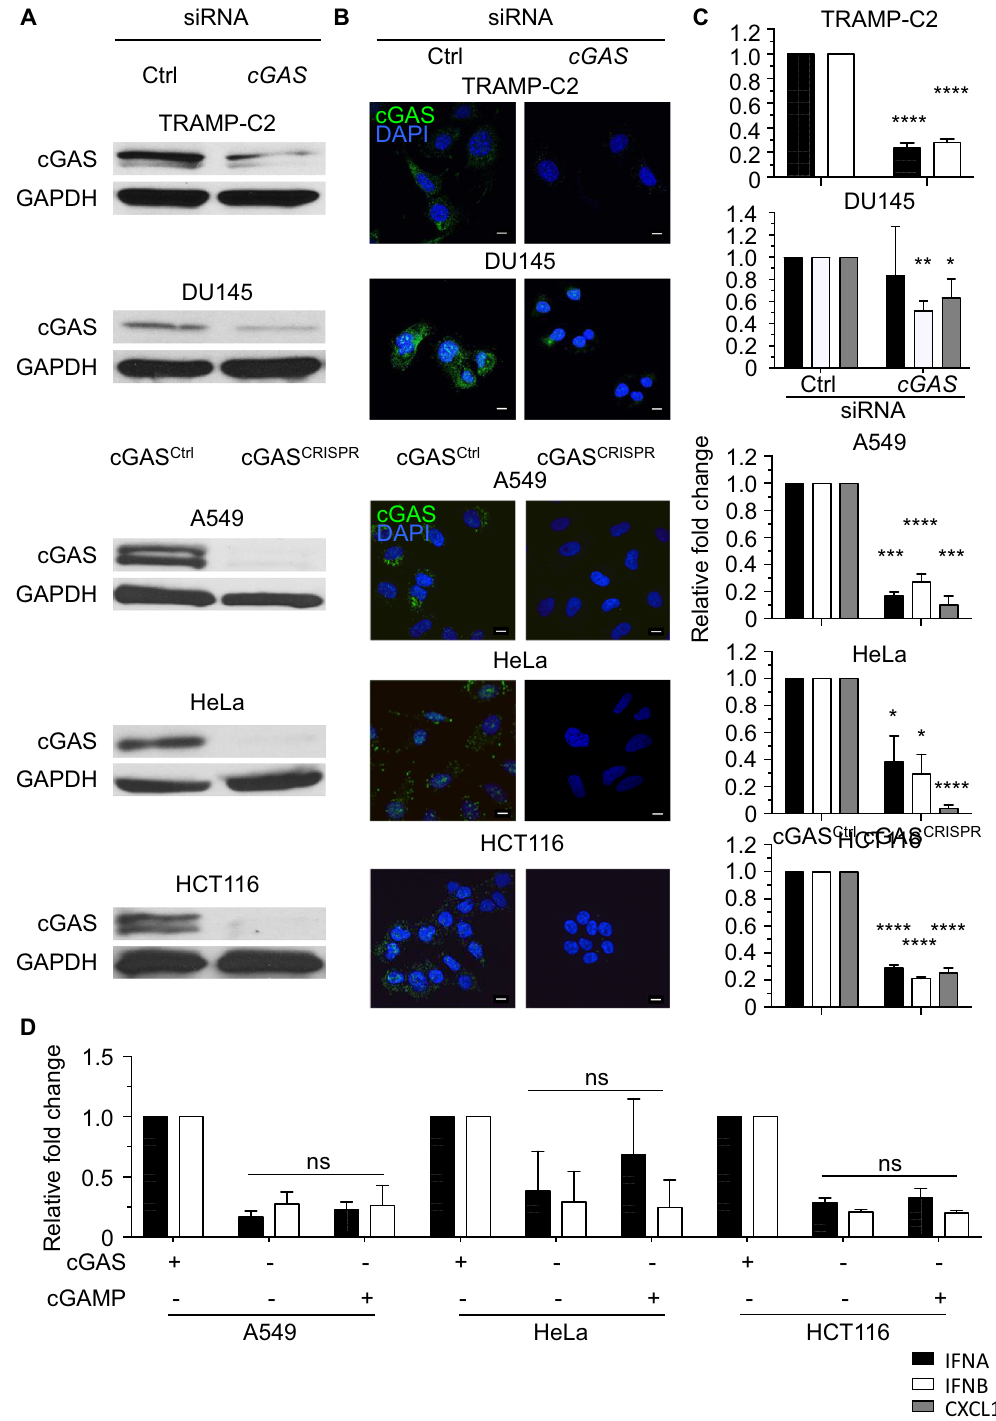
Figure 3. cGAS Does Not Contribute to STING Dysfunction in Human Cancer Cells. ( A ) Immunoblot analysis of cGAS and GAPDH expression in TRAMP-C2 and DU145 cells transfected with control siRNA or cGAS - specific siRNA and in cGAS-deficient (cGAS CRISPR ) or control (cGAS CTRL ) A549, HeLa, and HCT116 cells. ( B ) cGAS-deficient and wildtype cancer cells were stained for cGAS (green) in the presence of DAPI (blue) and analyzed by confocal microscopy. Scale bars denote 10 μm. ( C ) IFNA (black column), IFNB (white column) and CXCL10 (grey column) transcript levels in cGAS-deficient and cGAS expressing TRAMP-C2, DU145, A549, HeLa, and HCT116 cells were determined by real-time PCR. Transcript levels were normalized to levels in the respective control cells. ( D ) cGAS Ctrl and cGAS CRISPR A549, HeLa and HCT116 cells were treated with PBS (−) or 2 μg/ml cGAMP for 4 h followed by measuring IFNA (black column) and IFNB (white column) transcript levels by real-time PCR. Transcript levels were normalized to levels in untreated cGAS expressing cells. All data represent mean ± SD of 3 independent